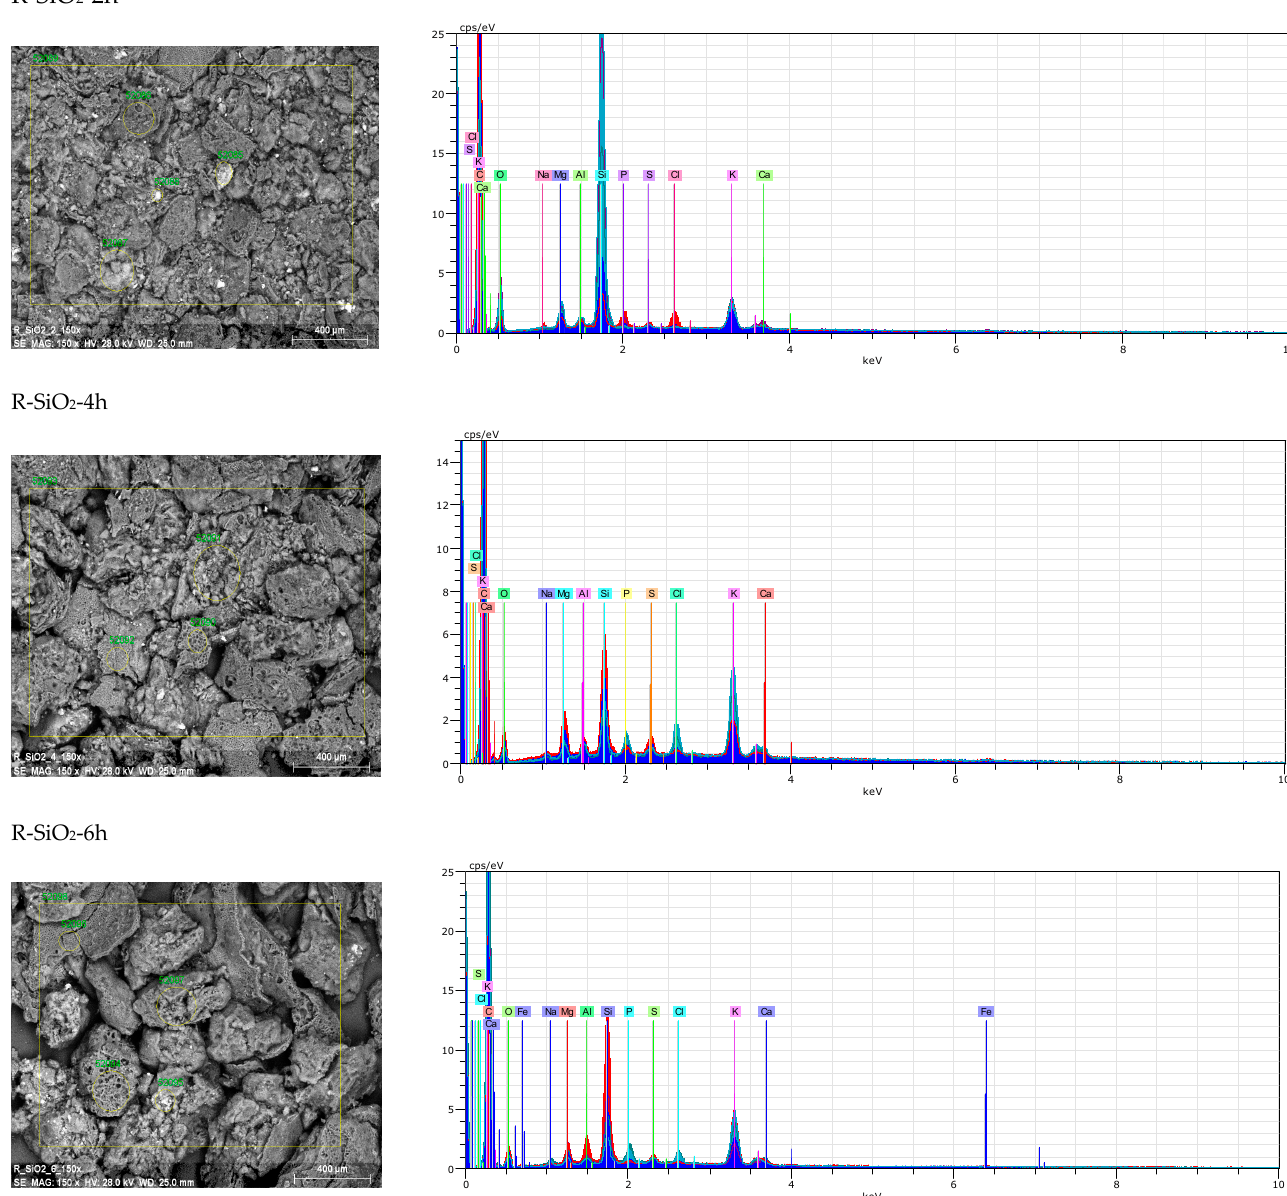
Figure 1. SEM/EDS analysis of the obtained silica-doped biochars.